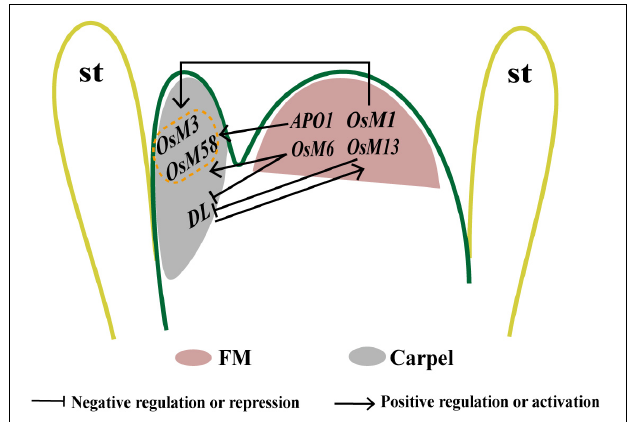
FIGURE 3 | Proposed model to illustrate the genetic interaction between rice floral homeotic genes in FMD in whorl 4. OsMADS3 and OsMADS58 are possibly activated by E-function genes OsMADS1 and OsMADS6 and also APO1 , the expression of DL may be repressed by OsMADS6 and OsMADS13 . In turn, DL may indirectly regulate OsMADS13 in a positive way. The onset of OsMADS13 expression in the final stage of the FM leads its transition to ovule